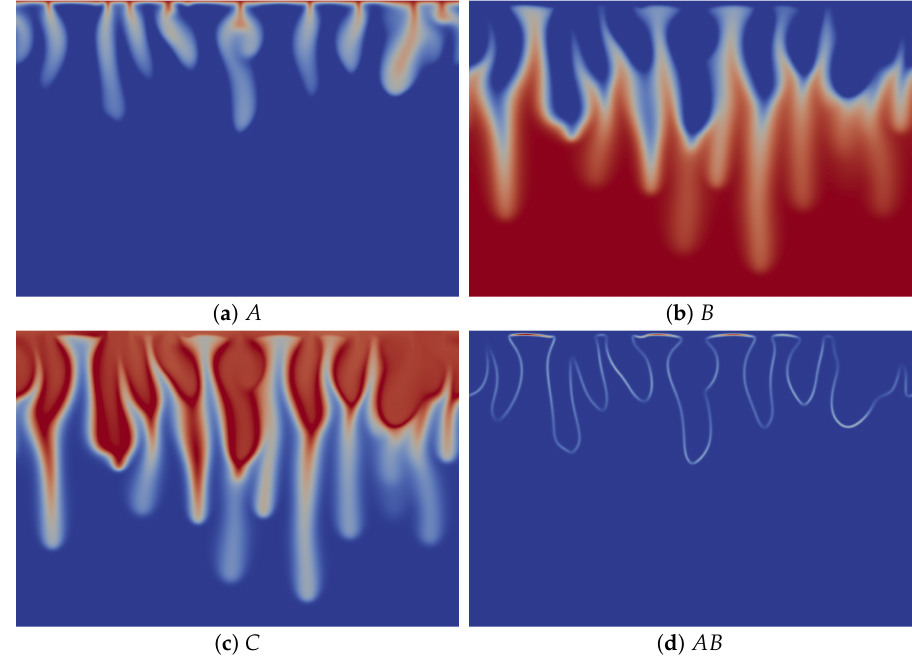
Figure 3. Concentrations fields of ( a ) A; ( b ) B; ( c ) C; and ( d ) reaction rate AB field corresponding to the density field shown in Figure 2d ( t = 20,000). Concentrations scale between zero (dark blue) and one (red), while the reaction rate AB scales between zero (dark blue) and 0.002